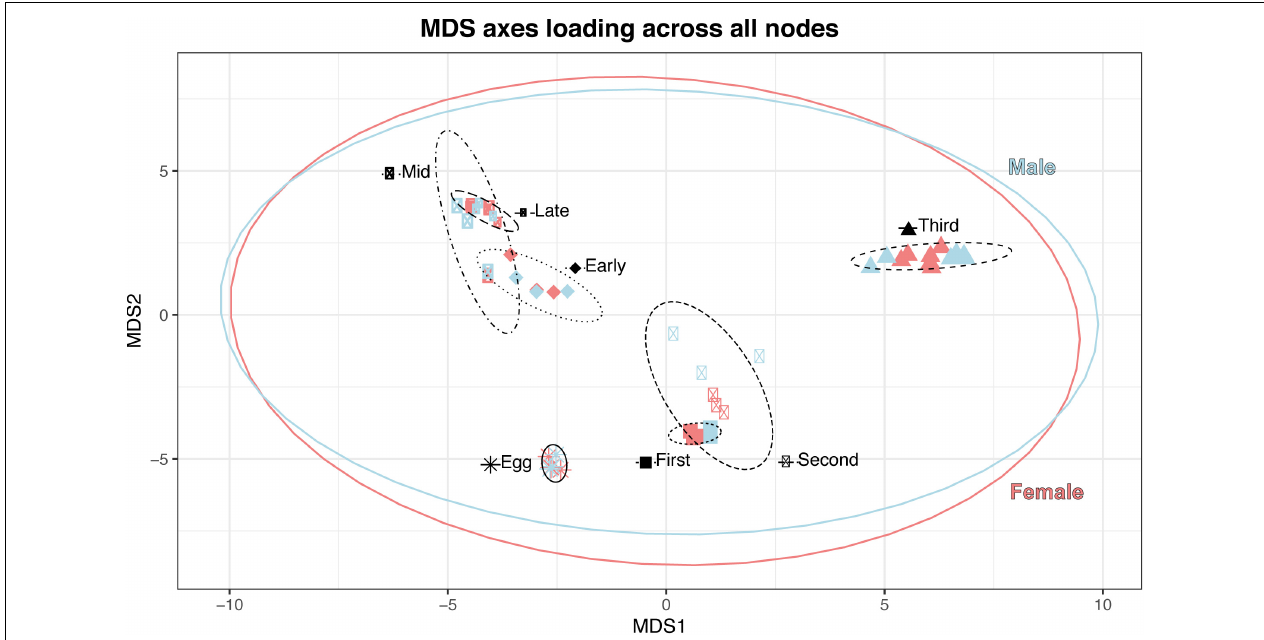
FIGURE 3 | Stage (as indicated by shape and ellipse linetype) is the most significant factor in clustering on MDS axes 1 and 2; sex (color) exhibits a smaller effect on clustering of immature samples, and the summary ellipses